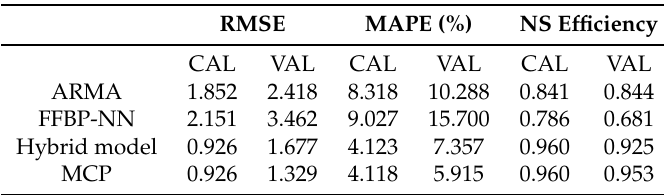
Figure 1. Average water consumption for the 24 h of each day [2]. Table 1. Performance Assessment: CAL and VAL mean the Calibration and Validation